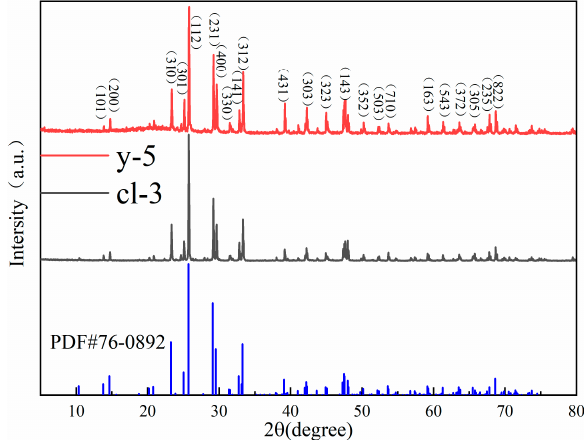
Figure 5. The XRD patterns of colorless and yellow